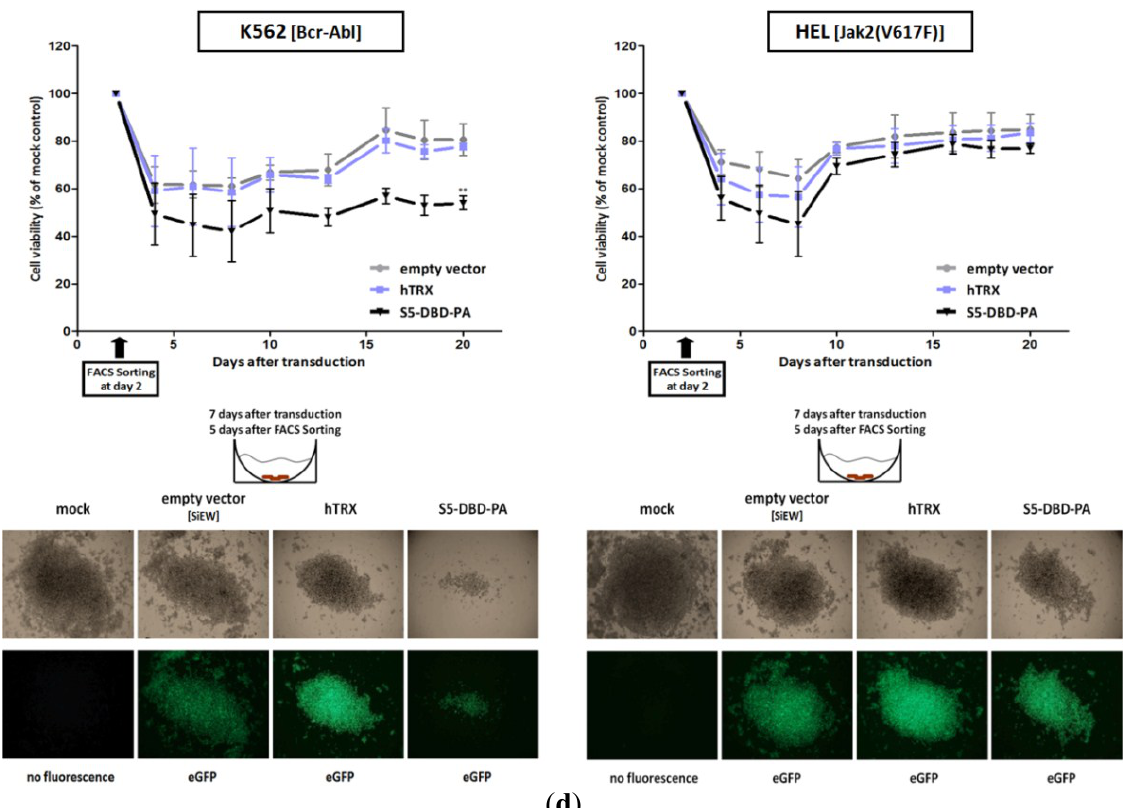
Figure 8. Reduction of K562 and HEL cell survival after infection with the S5-DBD-PA encoding lentivirus. ( a ) Bcr-Abl + K562 and Jak2(V617F) + HEL cells were infected with SiEW lentiviral vectors encoding either S5-DBD-PA, hTRX or an empty vector as controls. After 7 days, cell lysates were prepared and analyzed by western blotting for the expression of the encoded proteins with a Flag-tag antibody. Additional antibodies were used for the detection of Stat5 and P-Stat5 as well as for the analysis of eGFP fluorescence marker and Cyclin D1 target gene expression; ( b ) Proliferation and viability of the cells were monitored with the XTT-assay ( n = 4; Ø ± SD), cell growth was analyzed by counting the cumulative cell numbers at each passaging interval ( n = 3; Ø ± SD). Graphs indicate significantly reduced XTT-values (percentage of mock control) in comparison to empty vector expressing cells. * p < 0.05, ** p < 0.01, *** p < 0.001 (2-way-ANOVA with Bonferroni correction); ( c ) Analysis of apoptosis induction by Annexin V/7-AAD staining. 10 days after virus transduction cells were stained and analyzed by FACS. Divided FACS dot plots indicate unstained vital cells (lower left), early apoptotic cells positive for Annexin V (lower right), Annexin V/7-AAD double positive apoptotic cells (upper right) and late apoptotic/necrotic cells positive for 7-AAD (upper left); ( d ) eGFP expressing K562 and HEL cells were FACS sorted 2 days after infection with the lentiviruses and analyzed for changes in viability and growth by XTT conversion. Results are shown as the percentage of viable cells compared to mock control ( n = 3; Ø ± SD). Significantly reduced XTT-values in comparison to empty vector expressing cells are indicated. ** p < 0.01 (2-way-ANOVA with Bonferroni correction). Phase contrast and fluorescence microscopy images of accumulated cells at the round-bottom of assay-96 well plates were taken 7 days after virus transduction (5 days after cell sorting and